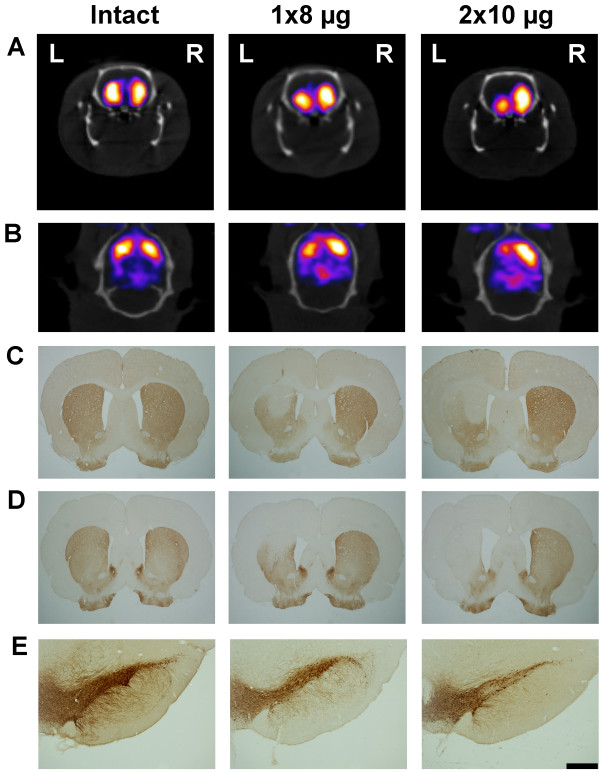
Representative pictures of striatal binding of [123I]β-CIT and immunohistochemical staining with dopaminergic markers. Striatal activity of [123I]β-CIT detected with SPECT/CT (coronal view (A) and transversal view (B)), DAT immunoreactivity in the striatum (C), TH immunoreactivity in the striatum (D), and nigral TH-immunoreactive cells (E) in intact and 6-OHDA-lesioned rats (8 and 2 × 10 μg 6-OHDA) at 4 weeks post-lesion. The orientation of the pictures is denoted in (A) with left (L) and right (R). Scale bar in (E) is 500 μm.